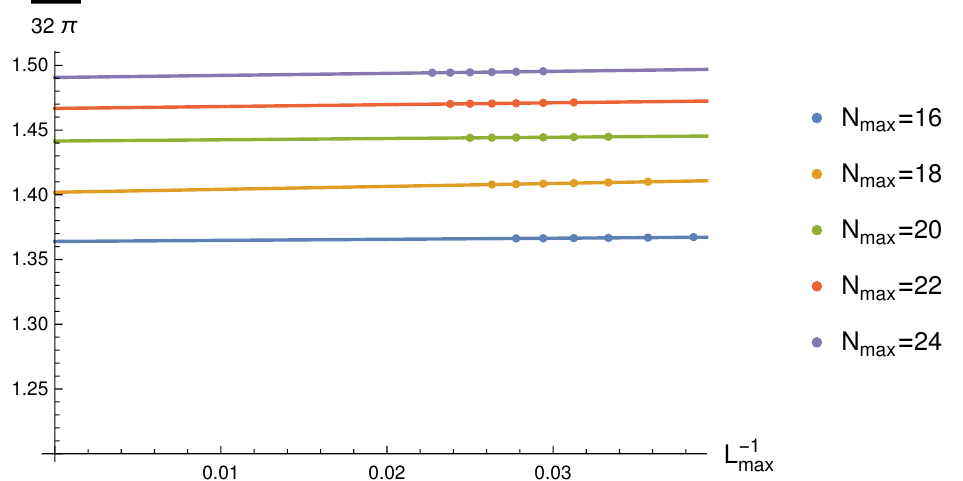
Figure 3 . Upper bound on the quartic coupling λ as a function of L − 1 numerical results. The solid lines represent the linear extrapolation in L − 1 points for each N max . Different colours correspond to different values of N max indicated in the right-hand side of the plot.